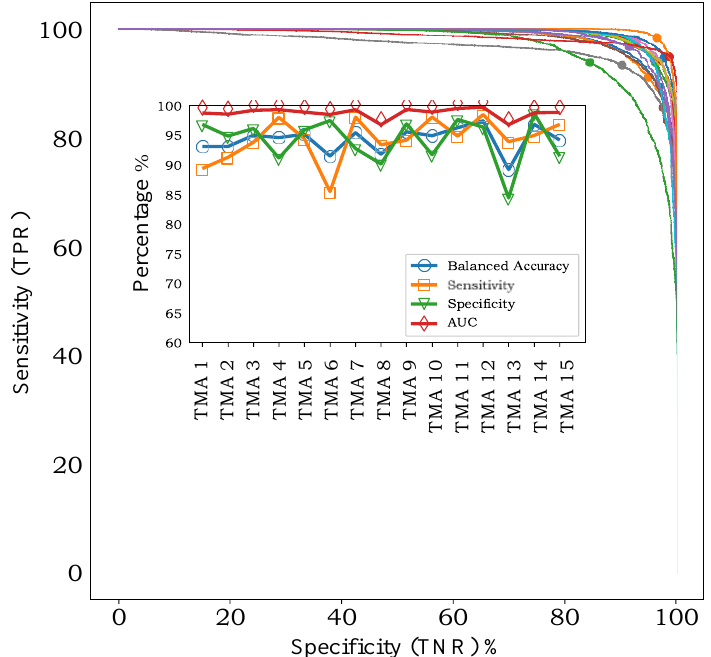
Figure 3. Colorectal cancer: Leave-one-TMA-out cross-validation results for classification of individual spectra. The main figure shows the ROC-AUC curves [true positive rate (TPR) vs. true negative rate (TNR)] for each TMA. The solid circle on each curve shows the operating point for a classification threshold of 0.5. The total area under the curve (AUC) for each TMA is shown in the inset, along with the corresponding accuracy, balanced accuracy, sensitivity, and specificity. The different colors of the ROC-AUC curves indicate each different TMA.